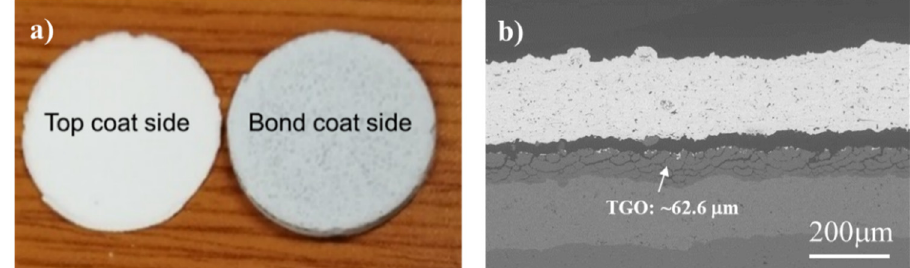
Figure 6. Photograph ( a ) and SEM image ( b ) of failed APS EBC after 600 steam cycling.